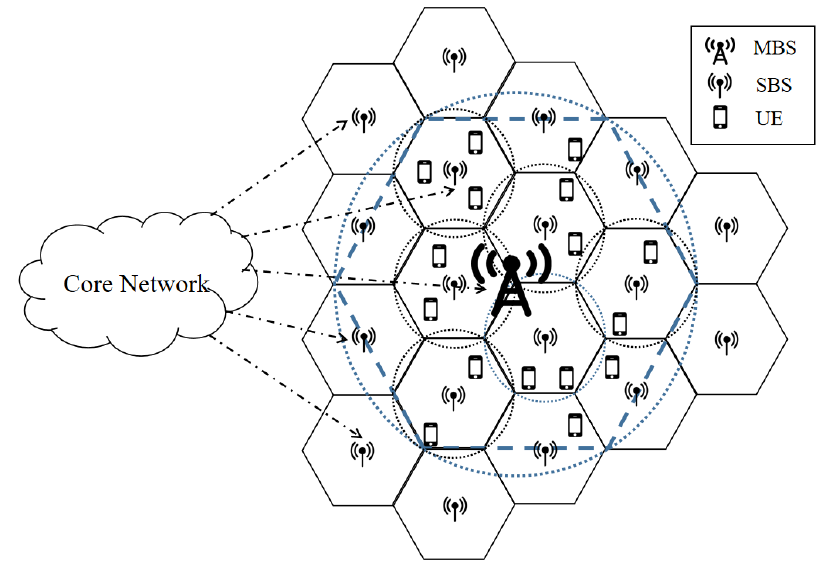
Figure 4. The deployment method of macro base stations (MBSs) and small base stations